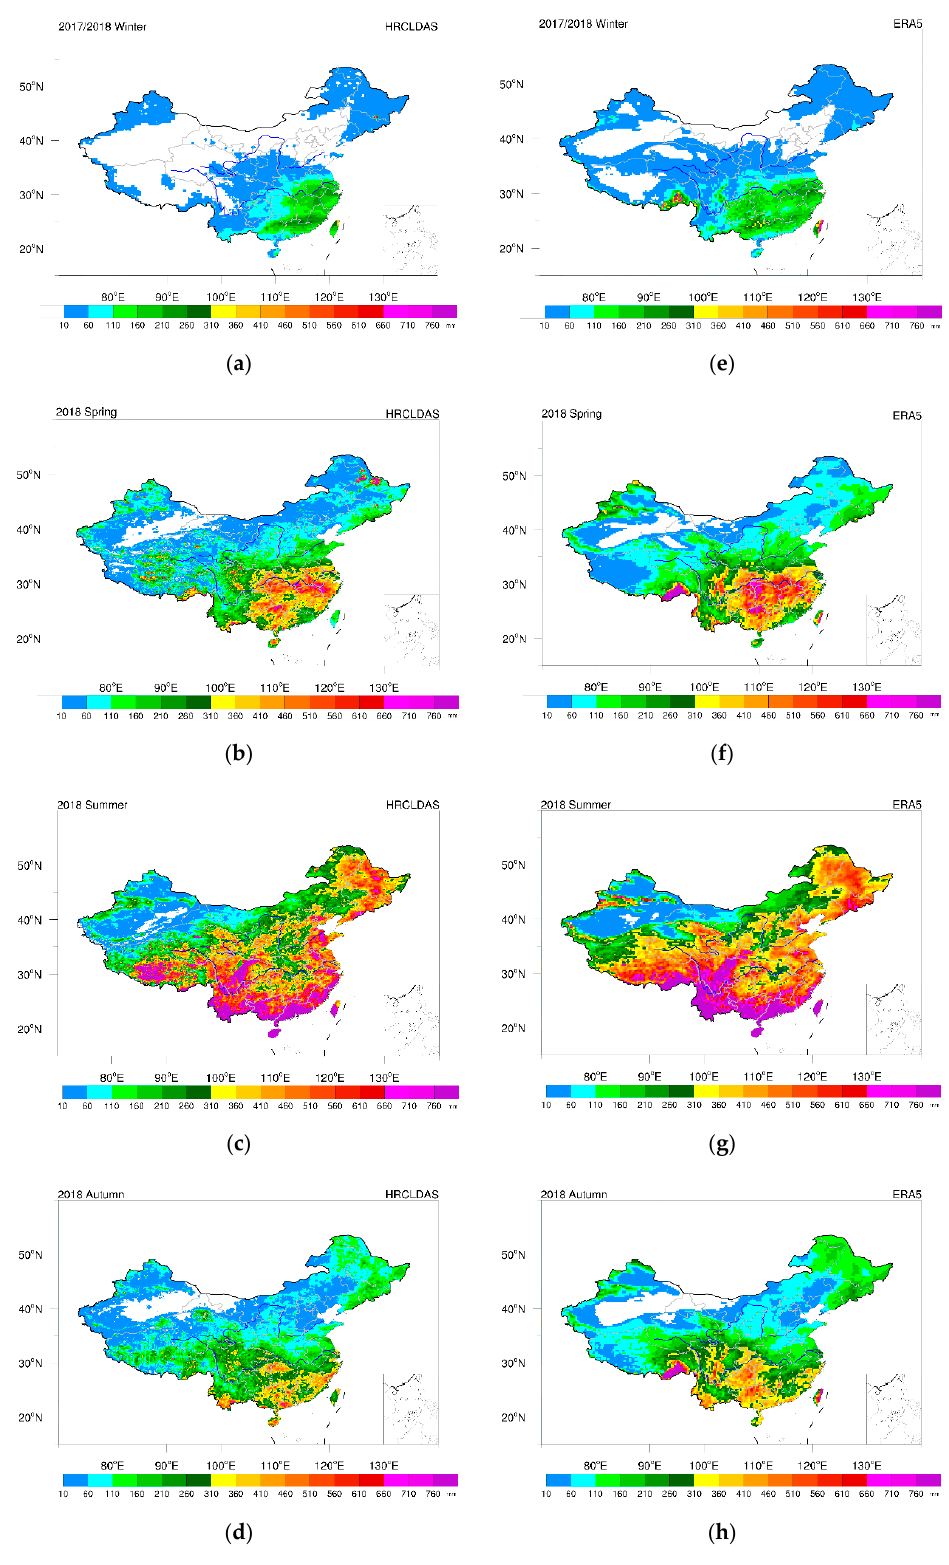
Figure 6. Distribution of accumulated precipitation in four seasons. ( a – d ) represent the spatial distribution of the accumulated precipitation of HRCLDAS in winter, spring, summer and autumn, respectively; ( e – h ) represent the spatial distribution of the accumulated precipitation of ERA5 in winter, spring, summer and autumn,